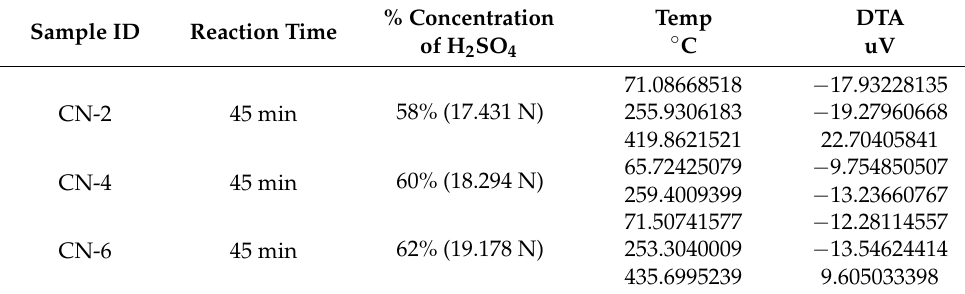
Figure 9. Thermal analysis: DTA curve of jute CNC samples for CN-2, CN-4, and CN-6. The temperature and heat flow ( µ V) of the DTA study of CN-2, CN-4, and CN-6 samples are outlined in Table 4. Table 4. DTA parameters of CNC samples.